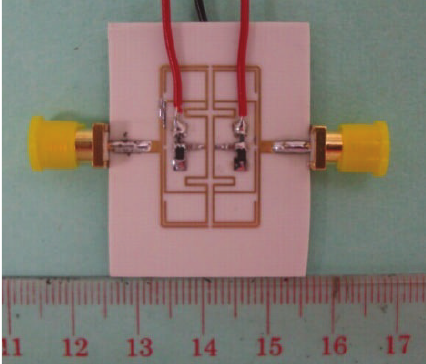
Figure 7: Photograph of the fabricated